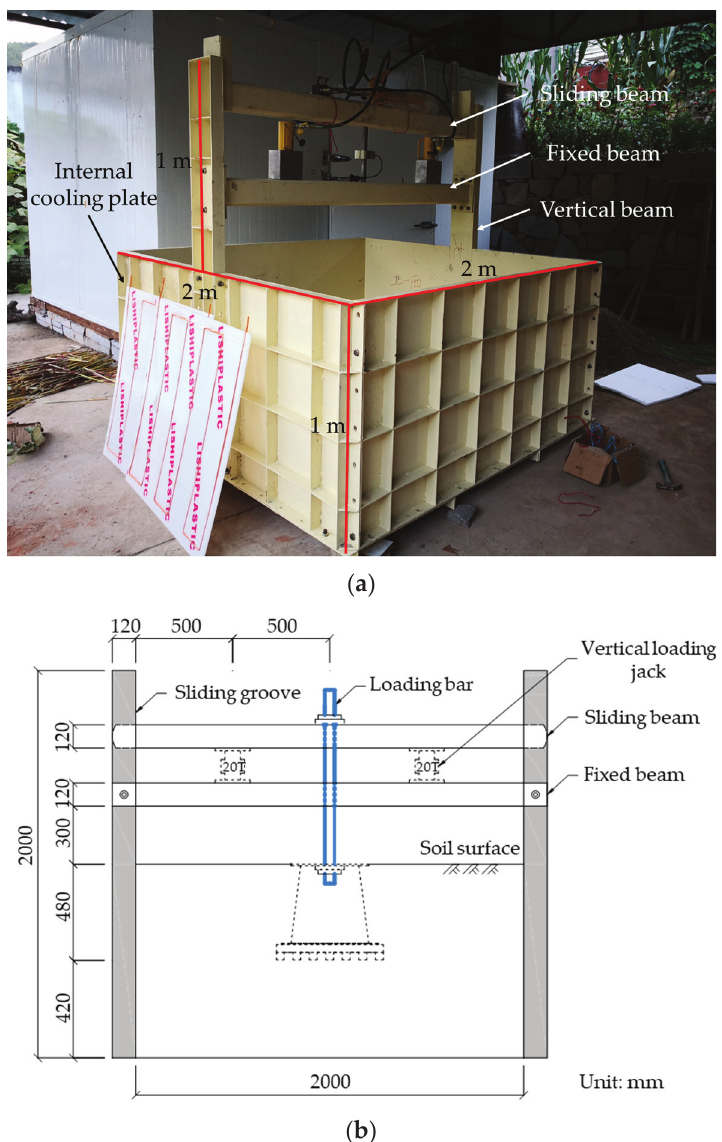
Figure 3. Test box and loading system: ( a ) photo of test box and ( b ) schematic drawing of loading system.